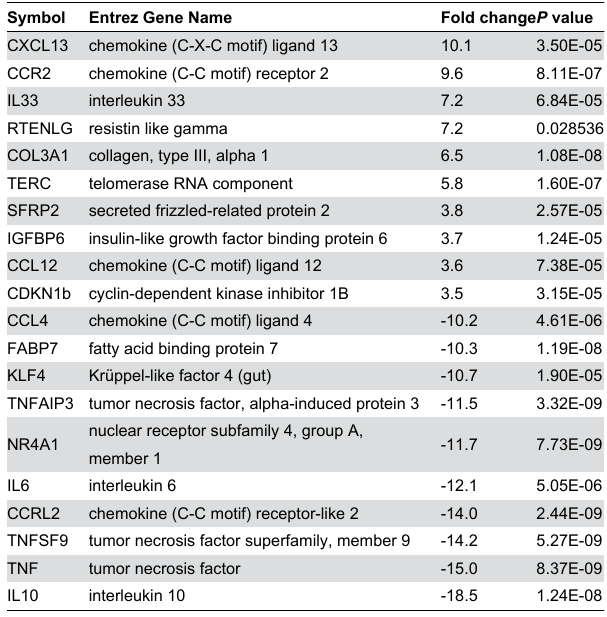
Table 11. Epididymal adipocyte genes displaying greatest differences in leptin deficient mice compared with age matched high fat diet (HFD) fed mice.